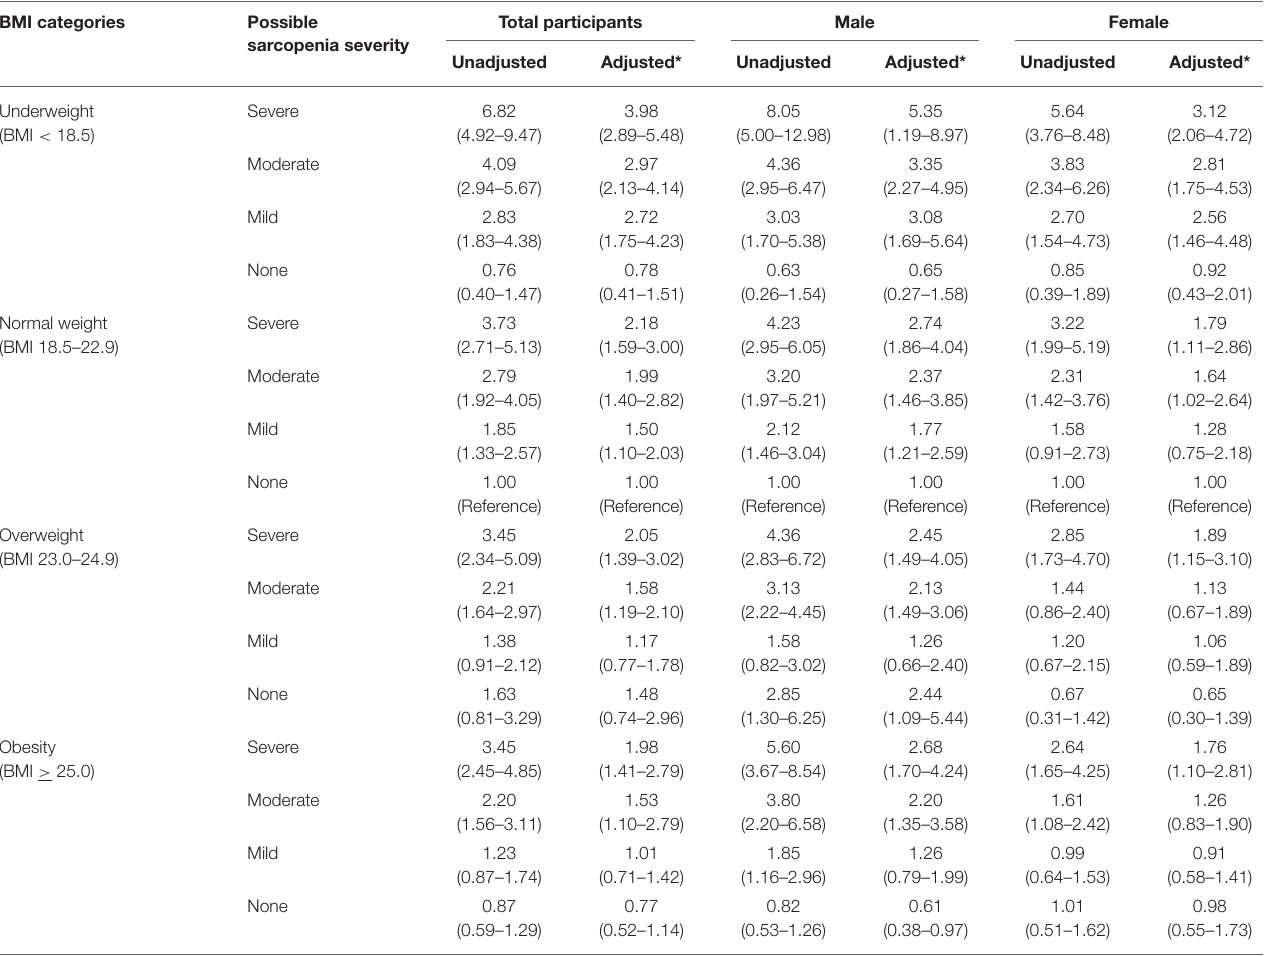
Adjusted* Unadjusted